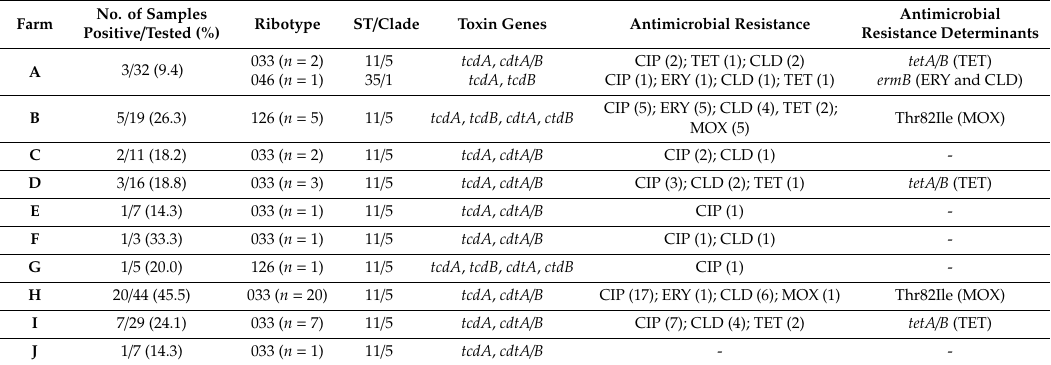
Table 1. The characterisation of C. difficile isolates in the study. CLD: clindamycin; CIP: ciprofloxacin;